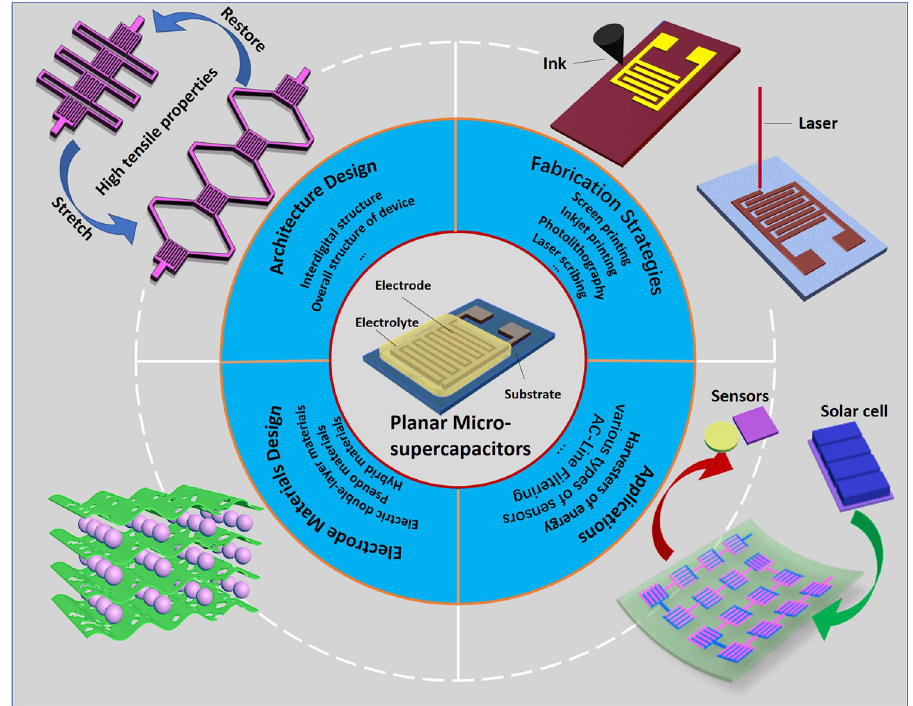
Fig. 1 Schematic illustrations of the components of MSCs and summary of this paper. Figures represent the composition of MSCs and main content of this